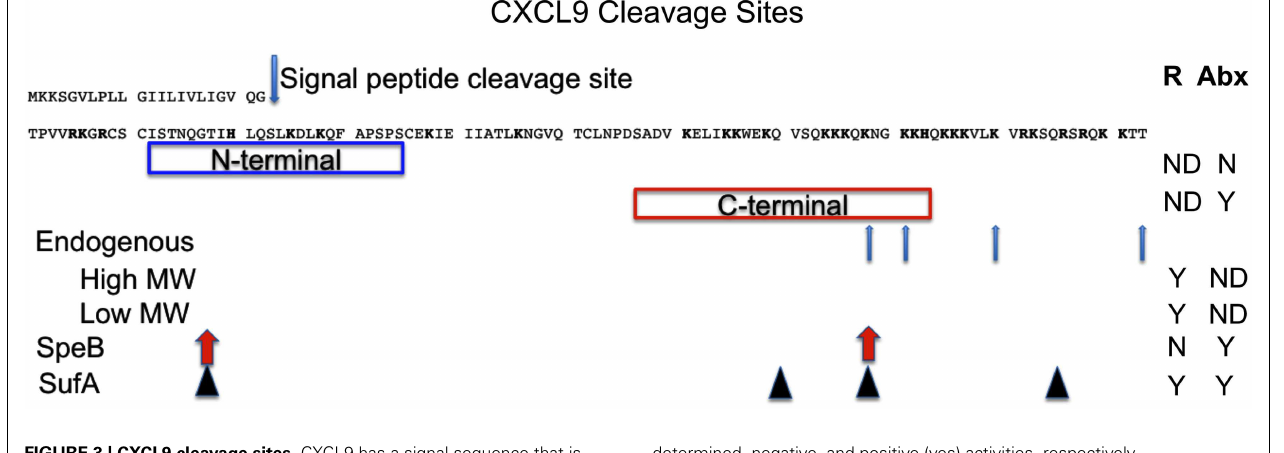
determined, negative, and positive (yes) activities, respectively. Endogenous CXCL9 has several truncated forms.These forms have been separated into two groups: high molecular weight (High MW) and low molecular weight (Low MW) groups for receptor activation. SpeB and SufA are two bacterial enzymes that cleave CXCL9. Arrows indicate where the processing sites are